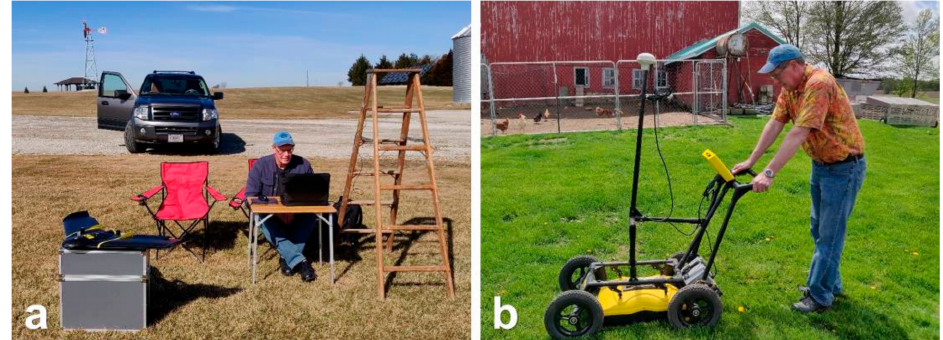
Figure 4. Equipment used in the investigation: ( a ) fixed-wing UAV, ladder with ground modem